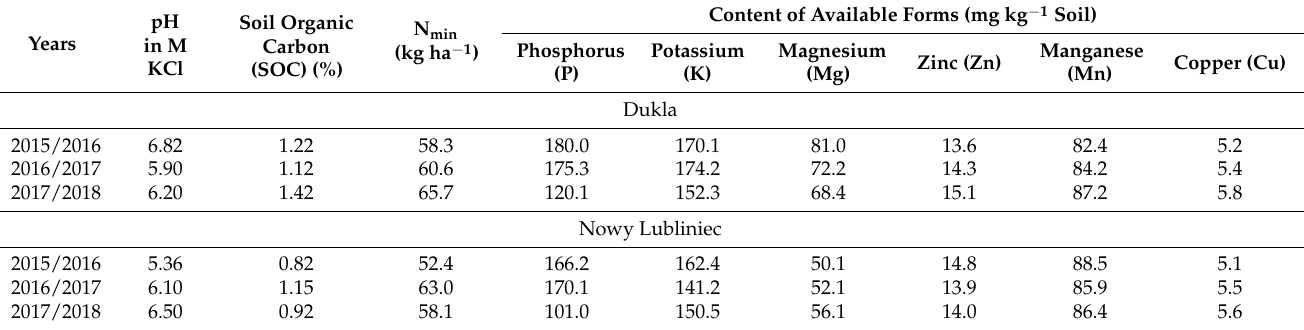
Table 1. Physical and chemical properties of the soil (0–35